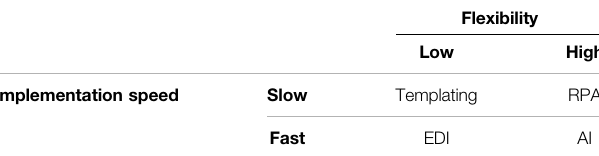
TABLE 2 | Comparative analysis of the performance of each technology. Source: own compilation of literature review fi